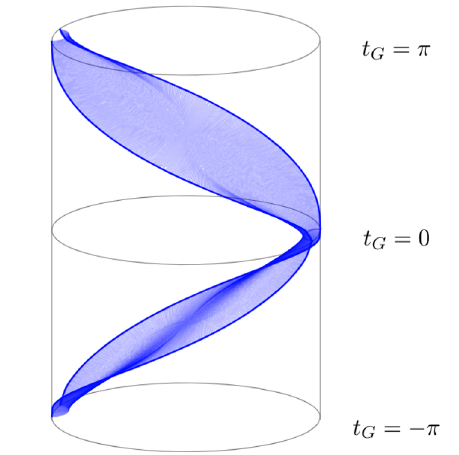
Figure 7. ETW brane in global Lorentzian AdS spacetime corresponding to the introduction of small disk-shaped hole in the Euclidean path integral constructing the vacuum state of a CFT on S 1 . The t g = 0 slice of the remaining geometry contains an arbitrarily large part of the t G = 0 slice of the original global AdS spacetime.